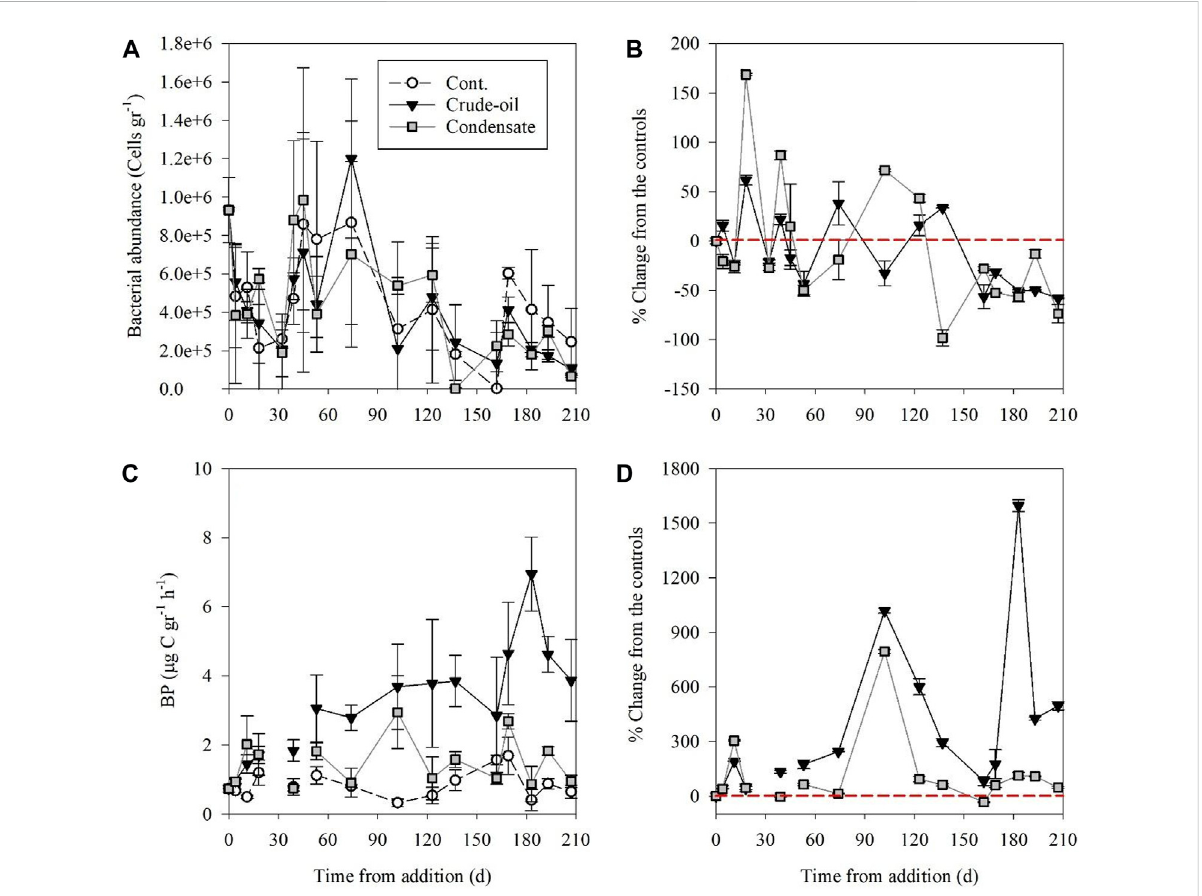
FIGURE 3 The temporal variability of sur fi cial sediment bacterial abundance (A, B) and bacterial production (C, D) rates following crude oil (black triangle) and gas condensate (grey square) additions and in the unamended control benthocosms (white dots). The values shown are the average of three independent “ biological ” replicates and their standard deviations. The red dashed line indicates no change between the treatments and the unamended controls at each time